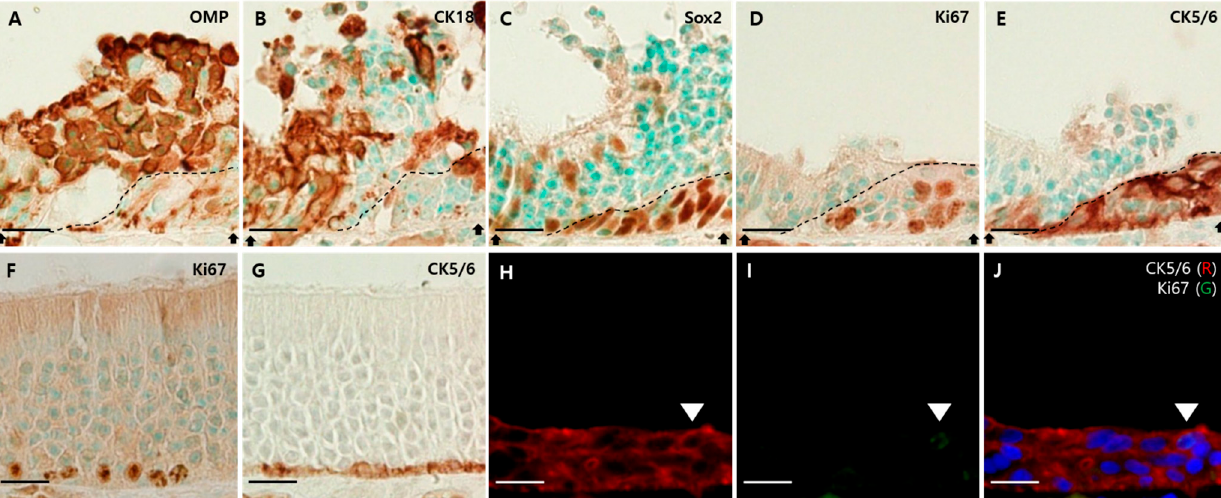
Figure 8. Regeneration of the MOE after viral infection. Scale bars = 20 μ m. ( A ) DAB staining with the antibody against OMP in the MOE of the infected group. OMP-positive cells are abundant in the damaged epithelium, but rare in the regenerating epithelium; ( B ) DAB staining with the antibody against CK18 in the MOE of the infected group. CK18-positive cells were abundant in the damaged epithelium, but rare in the regenerating epithelium; ( C ) DAB staining with the antibody against Sox2 in the MOE of the infected group. Sox2-positive cells were in the apical and basal layers of the damaged epithelium. In the regenerating epithelium, Sox2-positive cells formed multilayers; ( D ) DAB staining with the antibody against Ki67 in the MOE of the infected group. Ki67-positive cells formed multilayers in the regenerating epithelium; ( E ) DAB staining with the antibody against CK5/6 in the MOE of the infected group. CK5/6-positive cells formed multilayers in the regenerating epithelium; ( F ) DAB staining with the antibody against Ki67 in the MOE of the mock group. Ki67-positive cells were present in the basal layer of the MOE; ( G ) DAB staining with the antibody against CK5/6 in the MOE of the mock group. CK5/6-positive cells were present in the basal layer of the MOE. They formed a single layer. ( H – J ) Double immunofluorescence with antibodies against CK5/6 (red) and Ki67 (green). Sections were counterstained with DAPI (blue). In the superficial layer of the multilayer formed by CK5/6, both CK5/6- and Ki67-positive cells were observed.